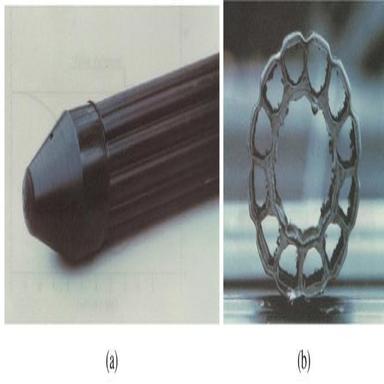
Footpiece (a) and cross-section (b) of coaxial BHE used formerly in Switzerland, made of PE with multi-chamber outer channel for turbulent flow and increased heat exchange (photos from Ref.).